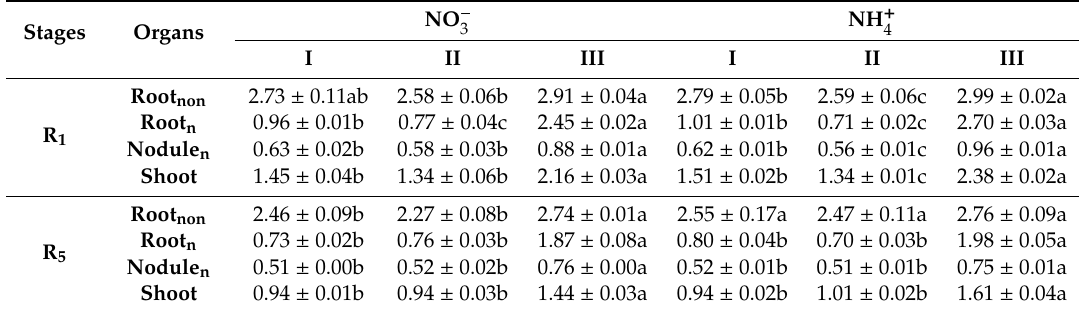
Table 2. 15 N abundance (%) in plant organs of soybean with dual